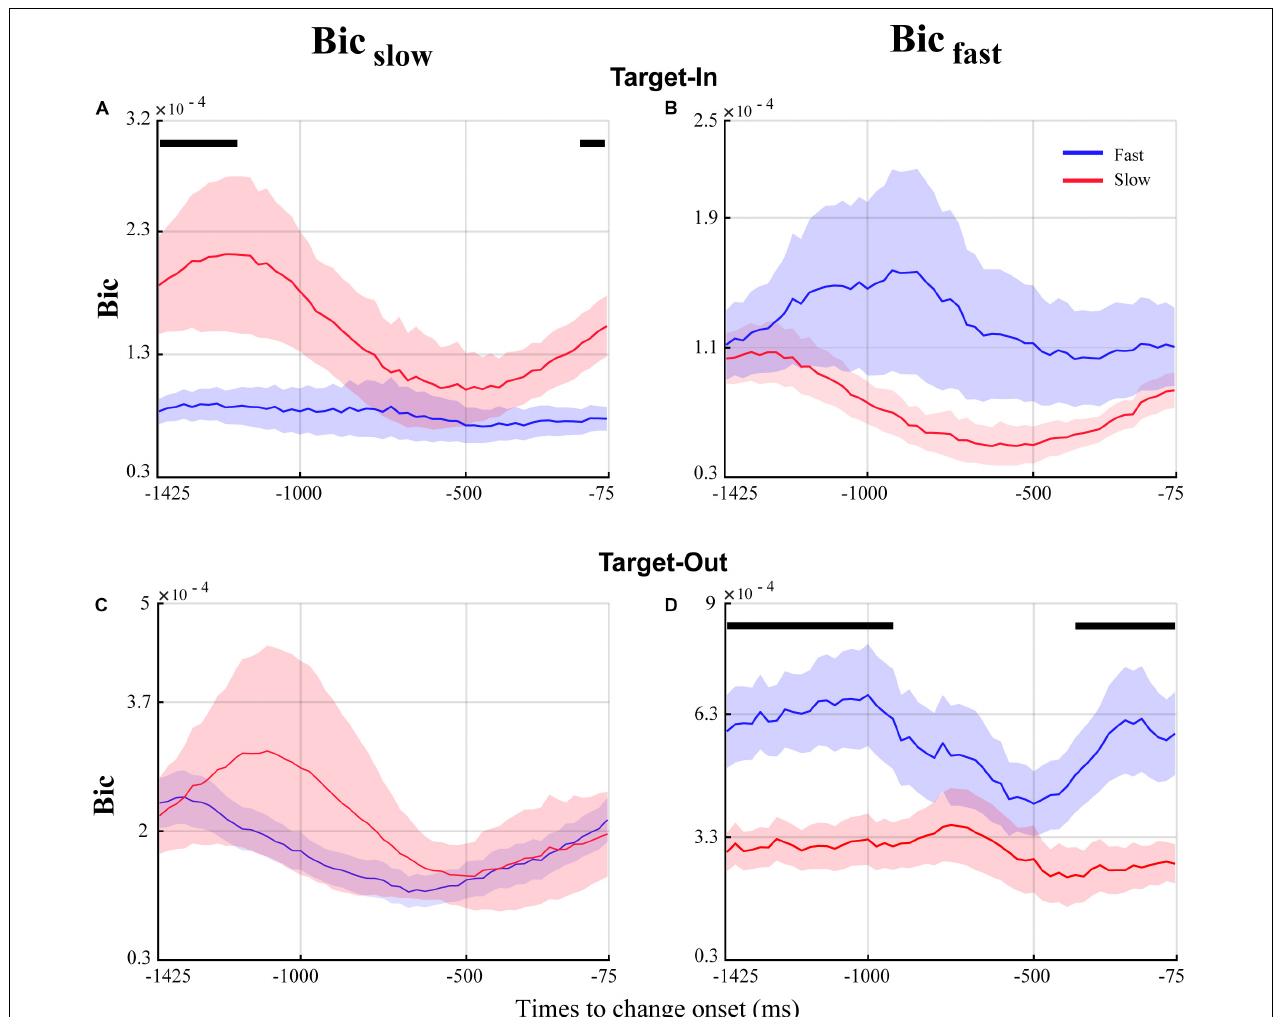
FIGURE 7 | Temporal dynamics of QPC in the fast and the slow trials for the time window before the target change. The blue and red curves show the temporal dynamics of QPC for the fast and the slow trials, respectively. The curves show the average bicoherence for the bifrequency component of the Bic fast (right column) and Bic slow (left column) groups shown in Figure 5 . The black lines on top of the traces mark the times that the QPC of the fast and the slow trials are significantly different ( p < 0.05, permutation test, FDR corrected for multiple